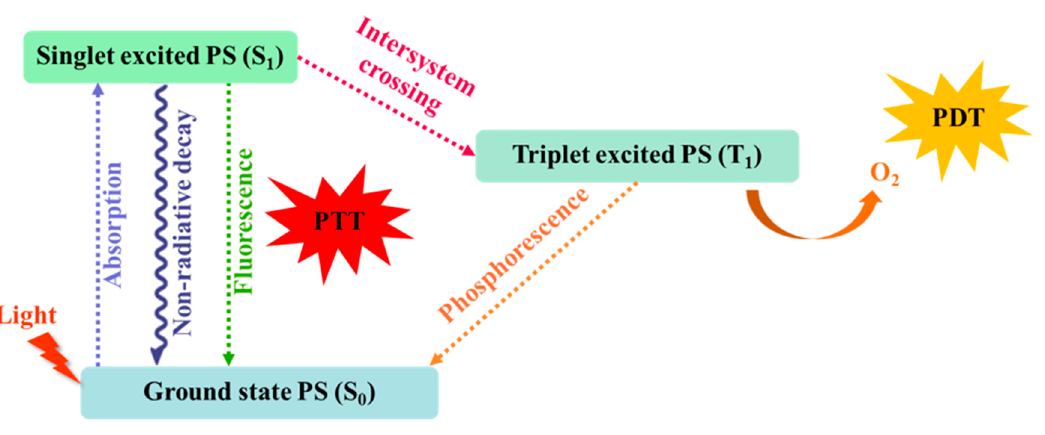
Figure 1. The Jablonski diagram of different energy transfer mechanisms.